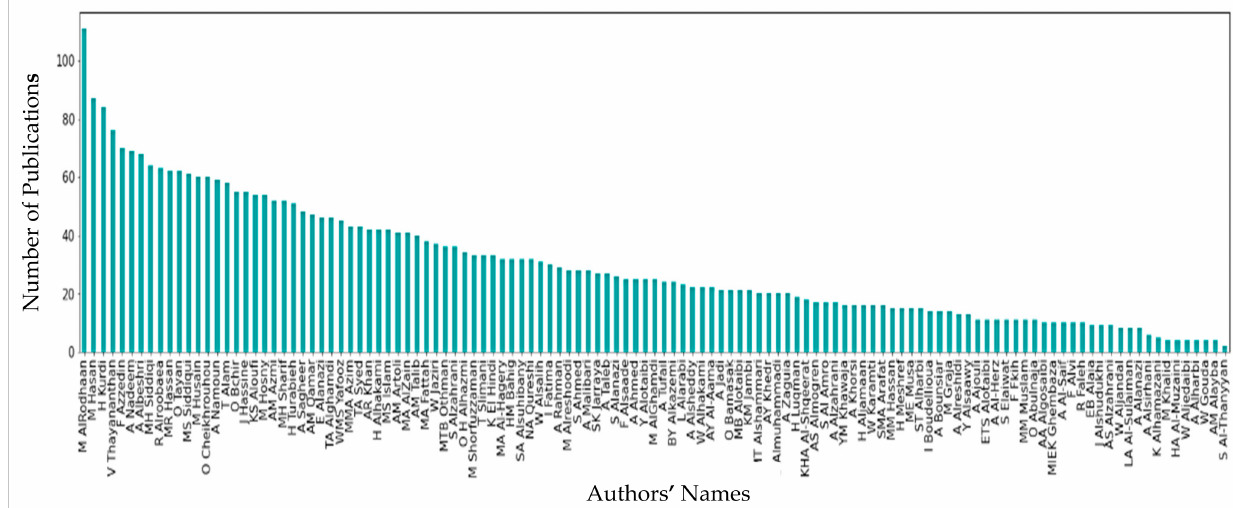
Figure 11. Number of publications for each author in descending